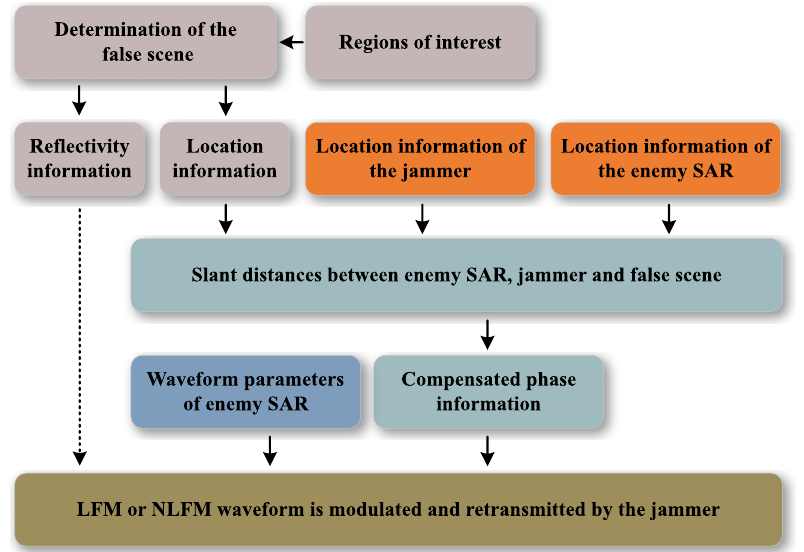
Figure 7. Flowchart of barrage jamming.